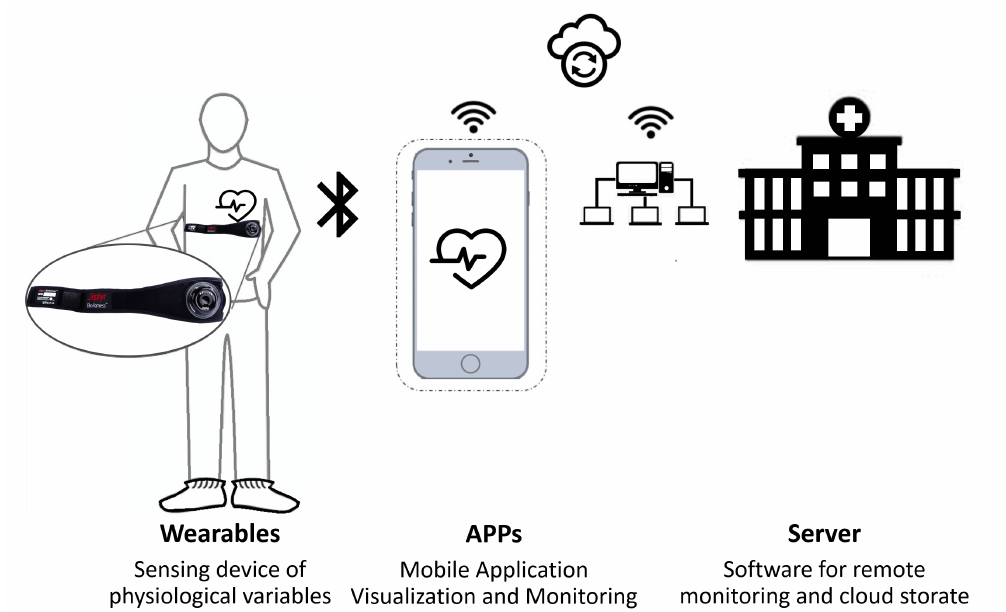
Figure 3. Basic scheme in an e-health